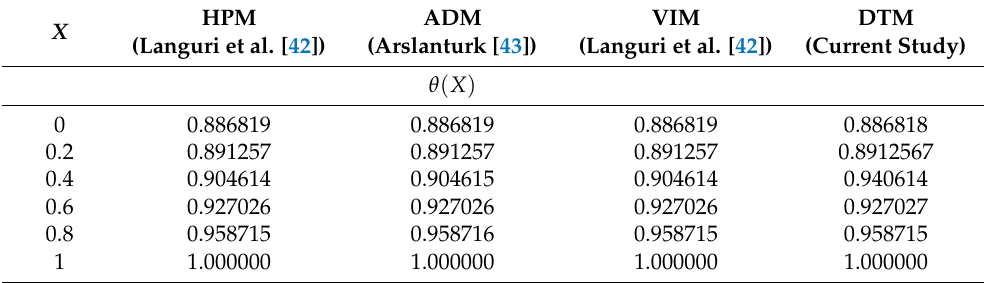
Table 2. Comparison of θ ( X ) obtained by different studies for rectangular fins by considering β = 0, G = 0, Nr = 0, θ a = 0 and N =